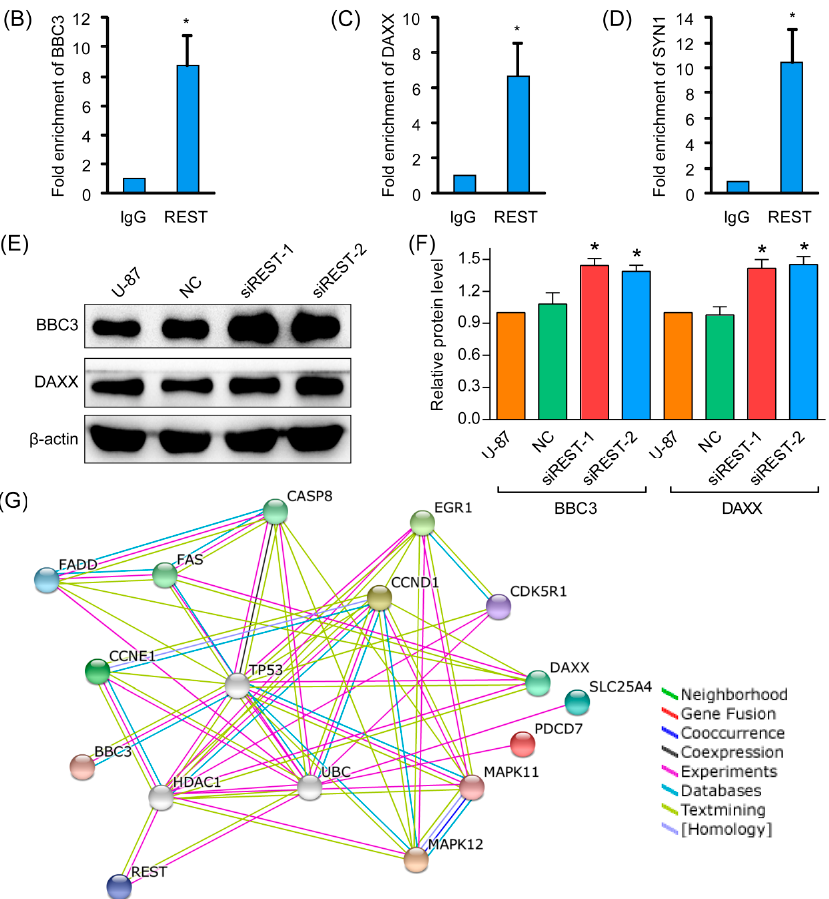
Figure 8. REST silencing elevated genes involved in cytostasis and migration inhibition. ( A ) The mRNA level of potential REST-regulated genes involved in cytostasis and migration inhibition were analyzed by real-time PCR, and GAPDH was used as an internal control; ( B , C ) ChIP (chromatin immunoprecipitation) assays were performed to pull down REST-DNA complexes from U-87 cells using anti-REST antibodies, and fold enrichment of BBC3 and DAXX was determined by real-time PCR; ( D ) SYN1 was used as a positive control; ( E , F ) The protein level of BBC3 and DAXX were verified by Western blotting; ( G ) The interactome was generated from the identified upregulated genes with the help of STRING database, using medium confidence (0.400) parameter, in order to identify highly-possible connections. * p < 0.05 compared with NC group.